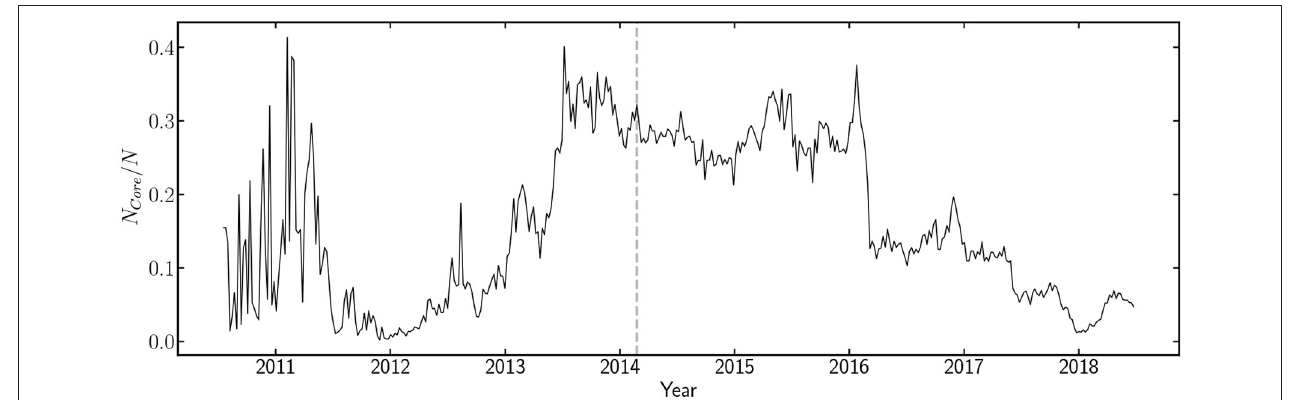
FIGURE 3 | Evolution of the percentage of nodes belonging to the core portion of the BUN on the weekly time scale. During 2012–2013 the core portion of the BUN steadily rises until it reaches ≃ 30 % of the network; then, during 2014–2015, it remains fairly constant; during the last 2 years covered by our data set (2016–2018), the core portion of the BUN shrinks and the percentage of nodes belonging to it falls back to pre-2012 levels. The vertical dashed line coincides with the bankruptcy of Mt. Gox.